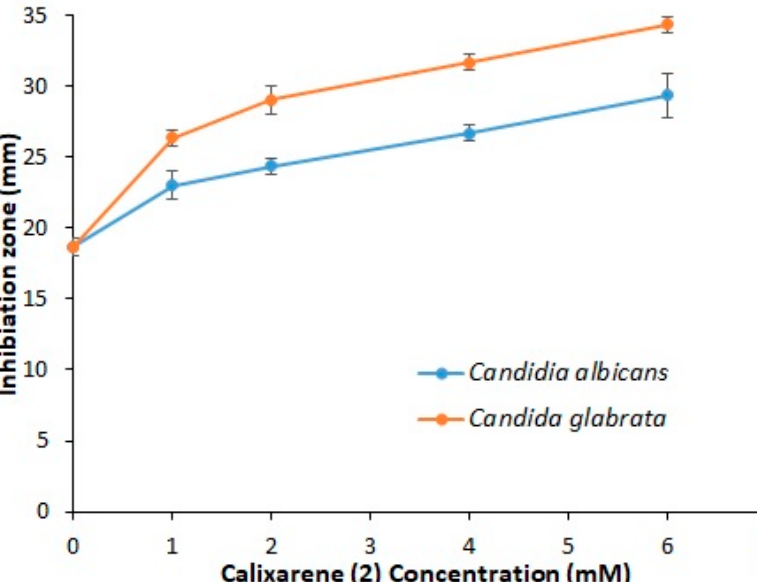
Figure 9. Effect of different concentrations of sulfonatocalix[4]naphthalene on inhibition zones of FZ against clinically pathogenic strains of Candida albicans and Candida glabrata ; ( n = 3, ±S.D.).